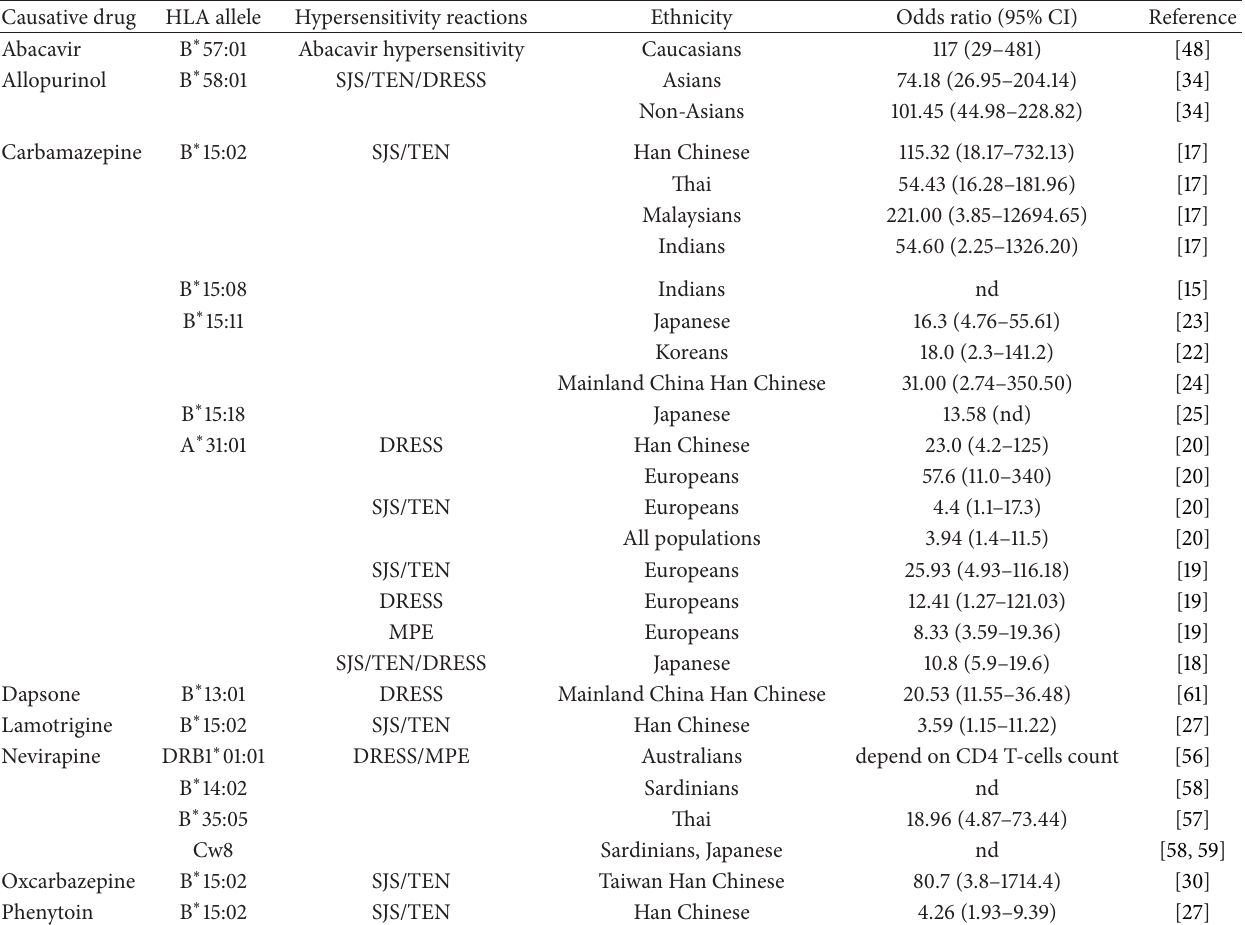
Table 1: Associations of SCARs and delayed-type drug hypersensitivity and HLA